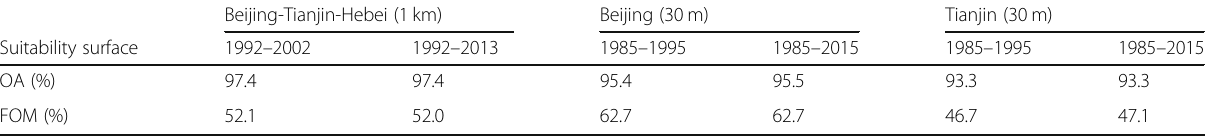
Table 1 Assessment of the urban sprawl modeling using suitability surfaces derived from different periods